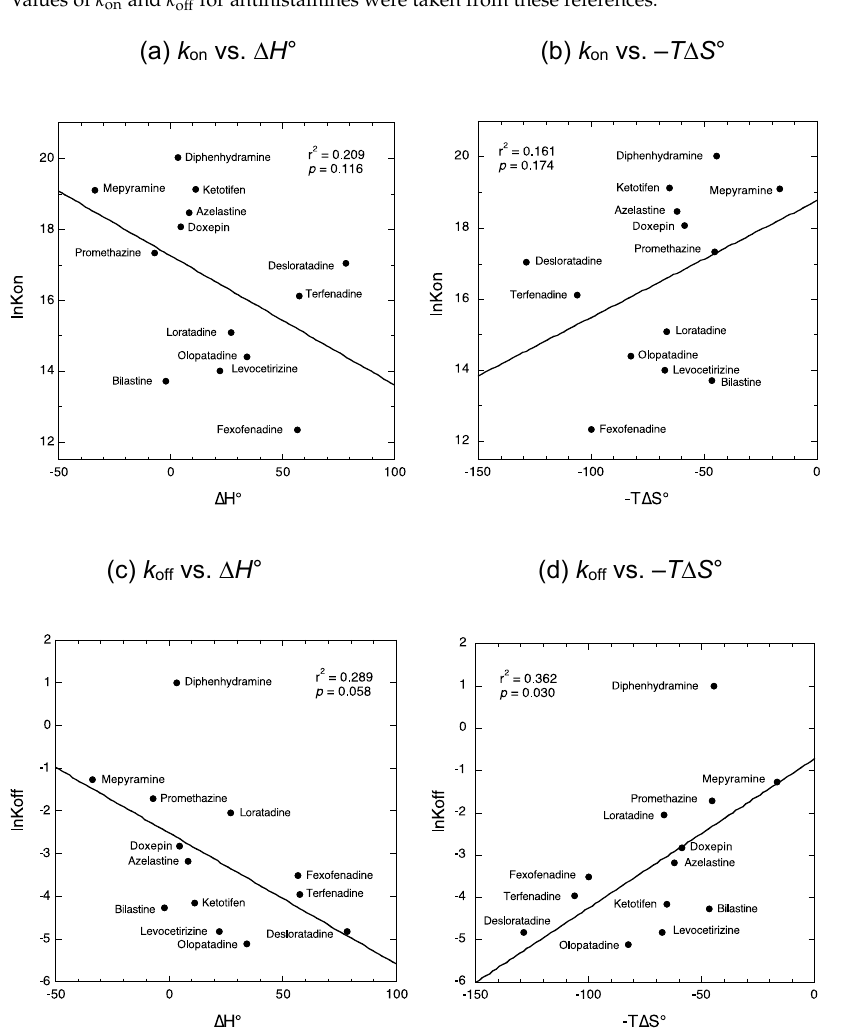
Figure 2. Relationship between the kinetic and thermodynamic binding parameters of antihistamines. Relationship between the values of ln k on vs. ∆ H °( a ), ln k on vs. – T ∆ S ° ( b ), ln k off vs. ∆ H ° ( c ), and ln k off vs. – T ∆ S ° ( d ). A significant relationship was observed between the values of ln k off vs. – T ∆ S ° ( d ). k on : rate constant of association; k off : rate constant of dissociation.